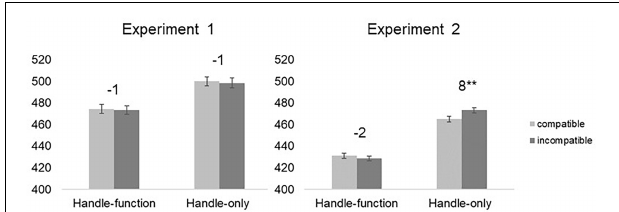
FIGURE 2 | Mean reaction times (RTs) as a function of Handle–Response Compatibility (compatible vs. incompatible) and Type of Object (handle-function vs. handle-only) for Experiment 1 (leftmost panel) and Experiment 2 (rightmost panel). Error bars indicate standard errors of the mean adjusted for within-participants designs (Loftus and Masson, 1994). The magnitude of the H-R compatibility effect (computed by subtracting mean RT for compatible trials from that for the incompatible trials) is reported on top of bars, separately for each type of object. Asterisks denote significant H-R compatibility effects ( ∗∗ p <